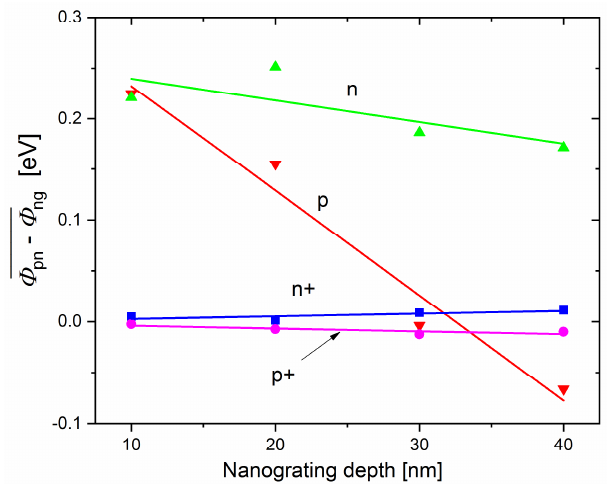
Figure 5. Dependence of the WF difference on the indent depth for the p- (red), n- (green), n + - (blue) and p + - (violet) type samples. Lines of corresponding colors are linear fits.